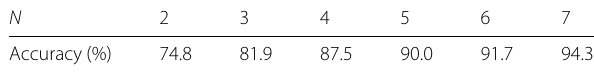
Table 8 Geometry-based channel inference in known channels